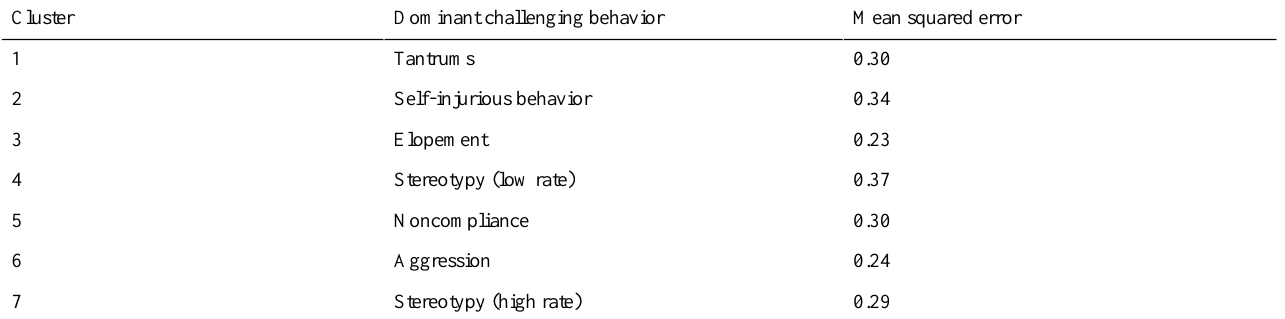
Table 2. Mean squared error comparison across